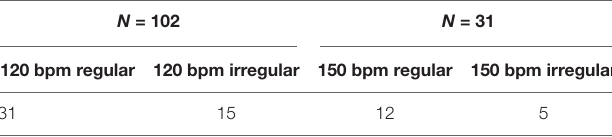
TABLE 4 | Number of participants achieving maximum score in each